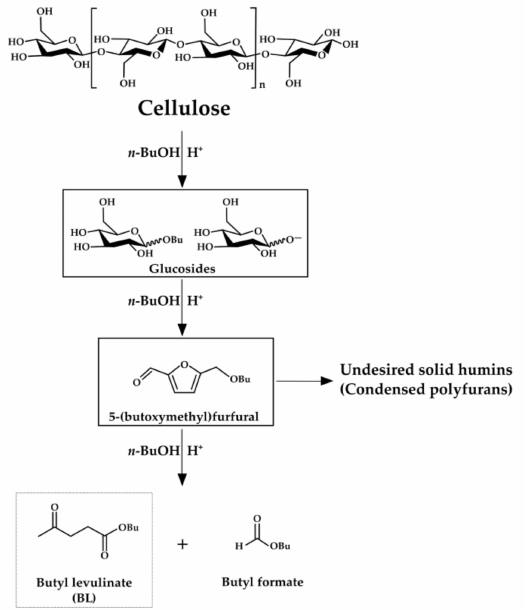
Figure 2. C6 fraction butanolysis pathway starting from cellulose feedstock (adapted from